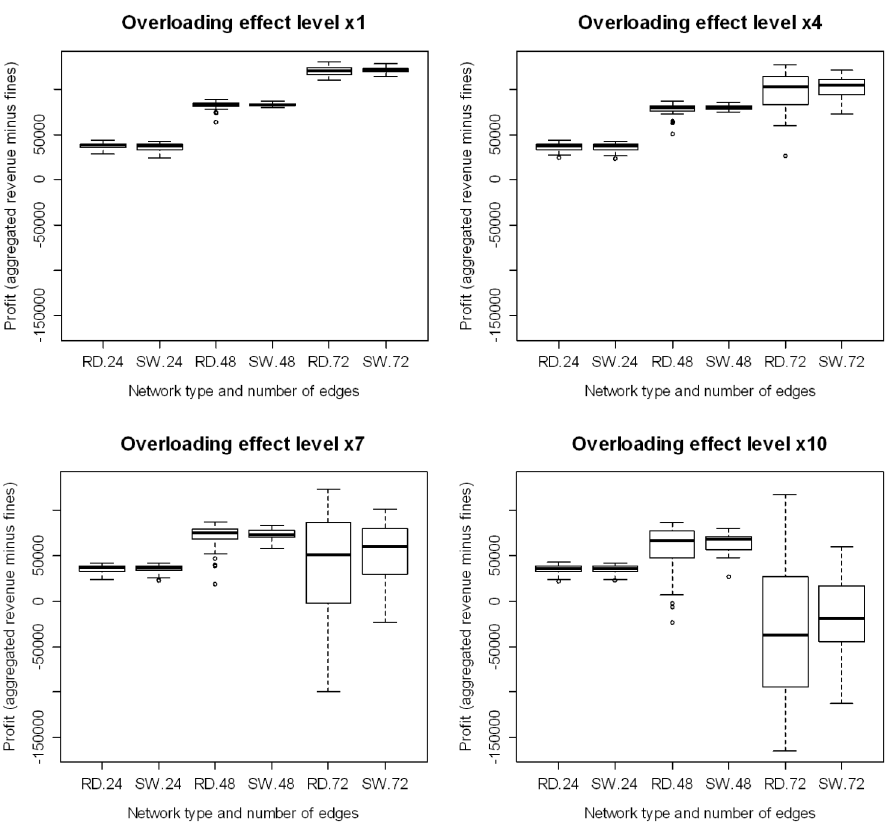
Figure 5. Changes in effect level for node overloading influence the shape of dependence between connectivity of the network and aggregated profit. This dependence is independent of network type [RD = Random, SW = Small world]